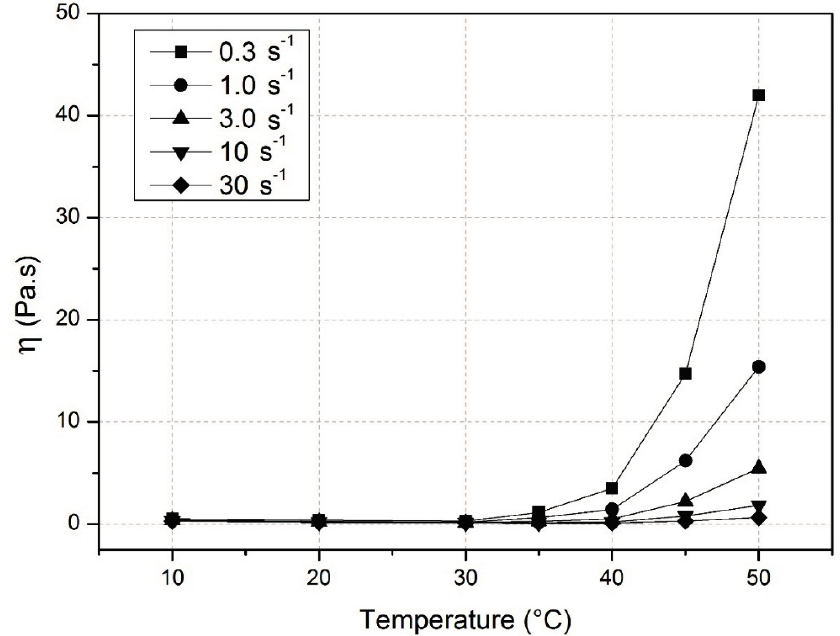
Figure 3. Viscosity obtained at different shear rates plotted as a function of temperature using Cox–Merz transformation of methylcellulose A4M solution at 10